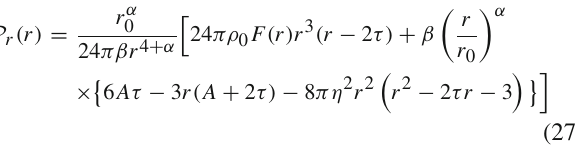
Figure 6 ensures that ρ( r ) + P r ( r ) < 0 corresponding to the specific choice of parameters ρ 0 = 0 . 004 kpc − 2 , α = 0 . 5 , β = 0 . 8 , r th = 1 kpc , r 0 = 2 kpc and the